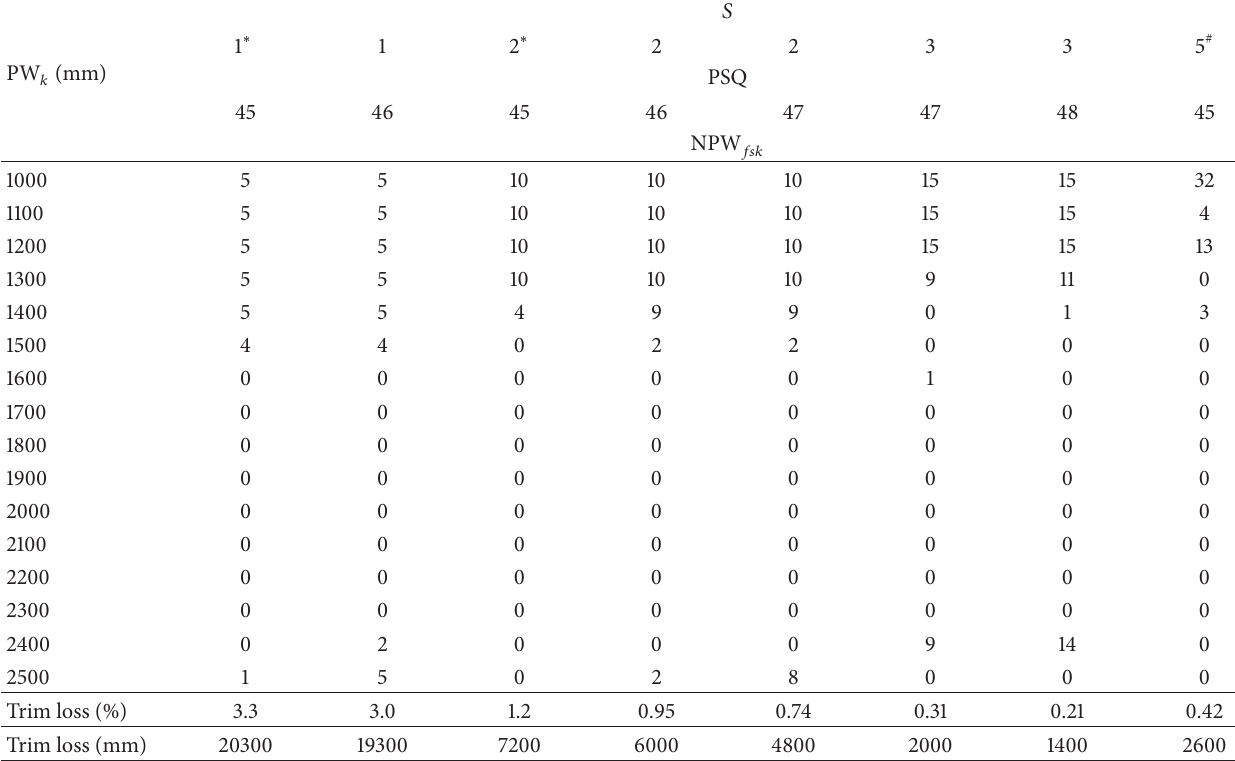
Table 6: Optimal solutions using our proposed method and the traditional method.